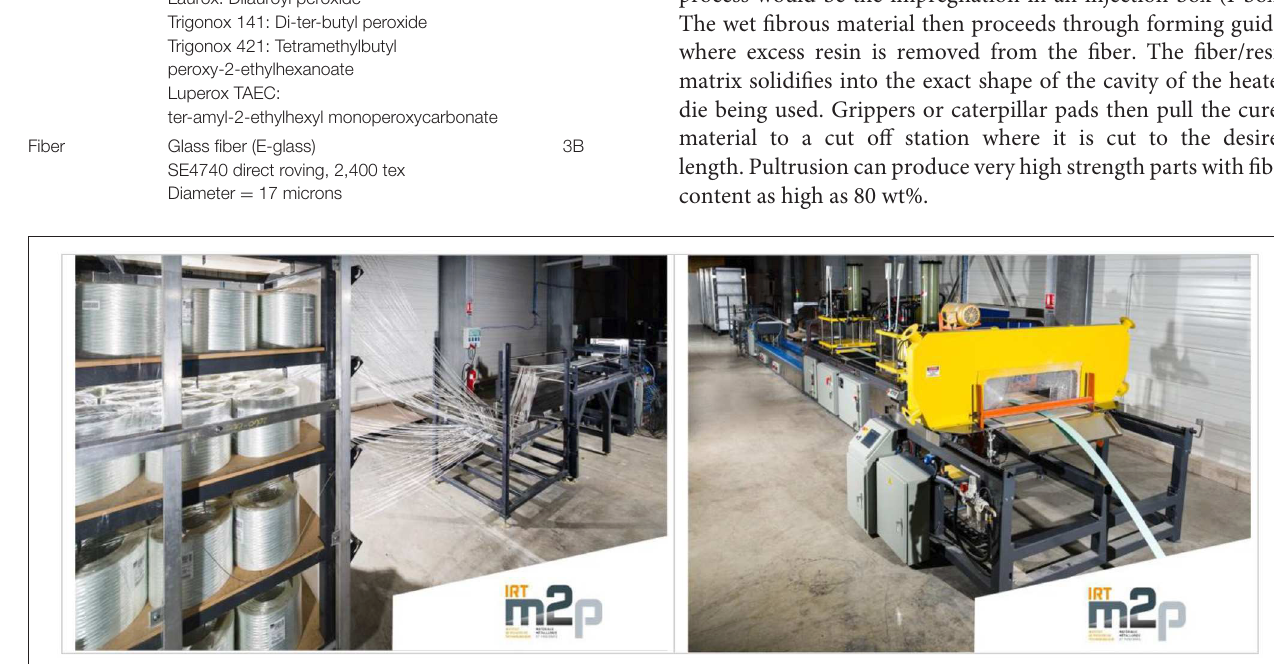
FIGURE 1 | Photos of a classical pultrusion line at